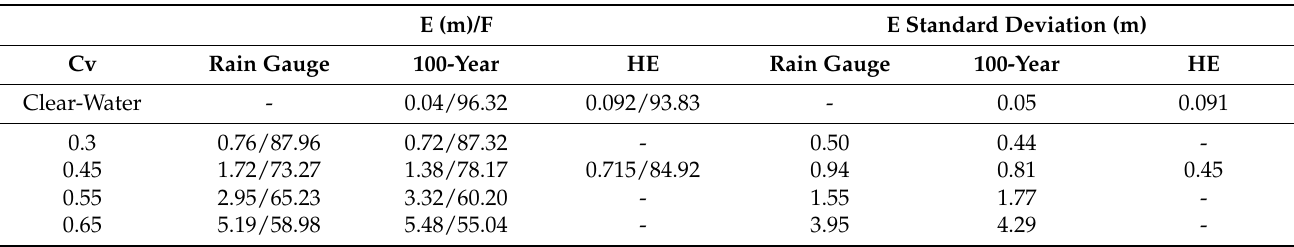
Table 6. Evaluation of model’s performance between sediment concentration scenarios (Cv) and hydraulic baseline (rain-gauge-clear-water) depth